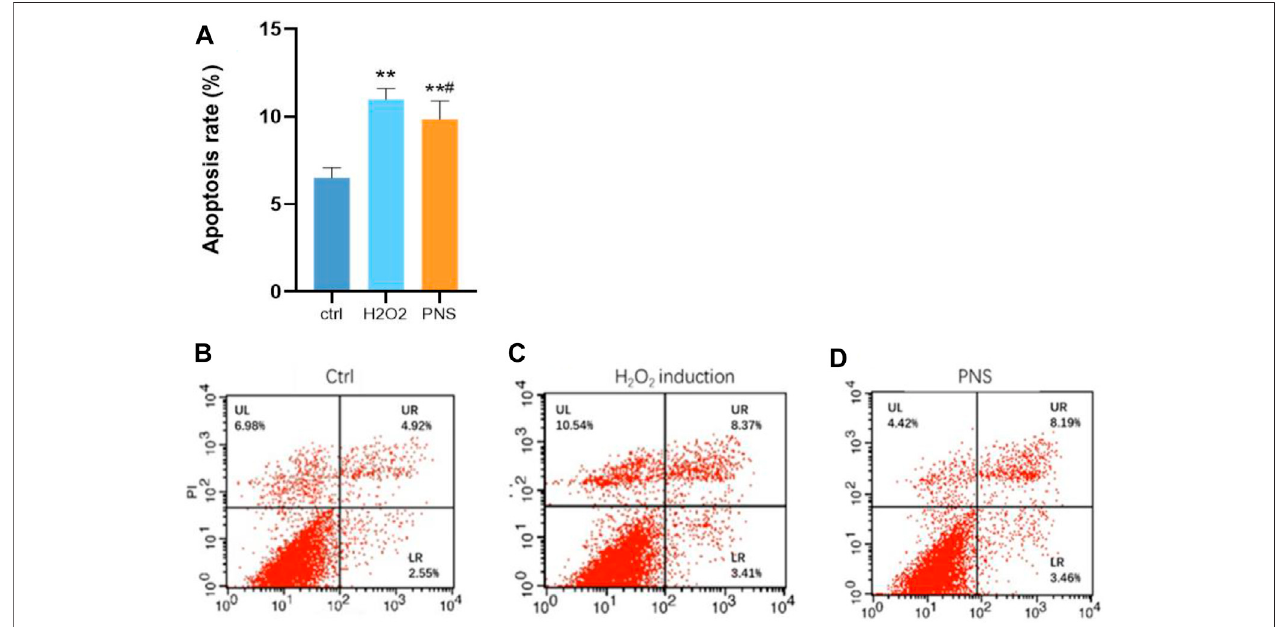
FIGURE 8 | Annexin V/PI apoptosis assay results. (A) Level of apoptosis in HUVECs; (B) control group; (C) H 2 O 2 group; and (D) PNS group. * p < 0.05 and ** p < 0.01, signi fi cantly different from the control group. # p < 0.05, signi fi cantly different from the H 2 O 2 group.